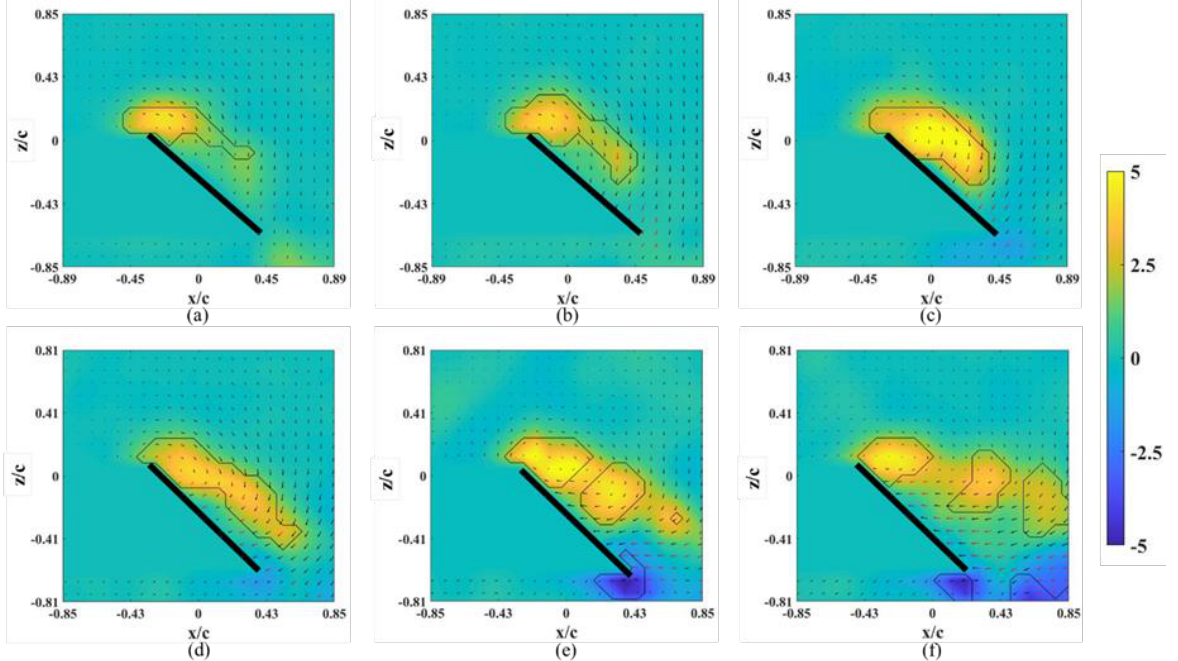
Figure 5. Vorticity contours around the base wing model without alula-VG on different x-z planes at α = 45°. ( a ) r * = 0.36, ( b ) r * = 0.46, ( c ) r * = 0.56, ( d ) r * = 0.66, ( e ) r * = 0.76, and ( f ) r * = 0.8.